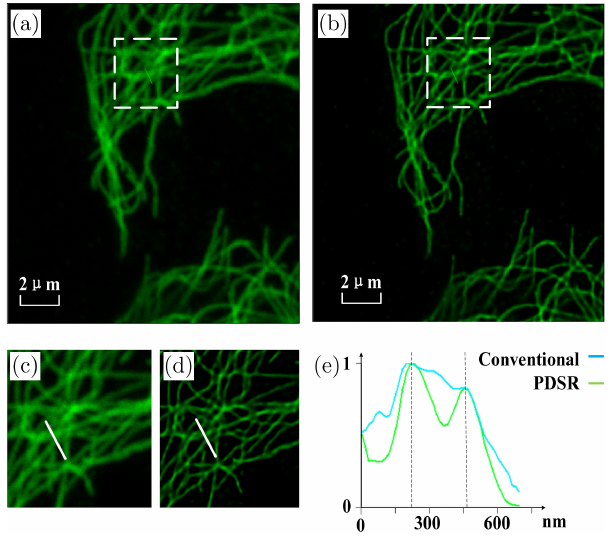
Fig. 4. The images of a ¯xed U20S cell captured by conventional confocal microscopy and PDSR microscopy. (a) The image cap- tured by conventional microscopy. (b) The image captured by PDSR microscopy. (c, d) The local area indicated, respectively, in the dashed box in (a) and (b). (e) The line pro¯les along the traces indicated by white line. The images were captured with 6 (cid:1) s acquisition time per pixel and 30nm step size per scan position. The microtubules were labeled by Alexa plus 488. Scale bar: 2 (cid:1)